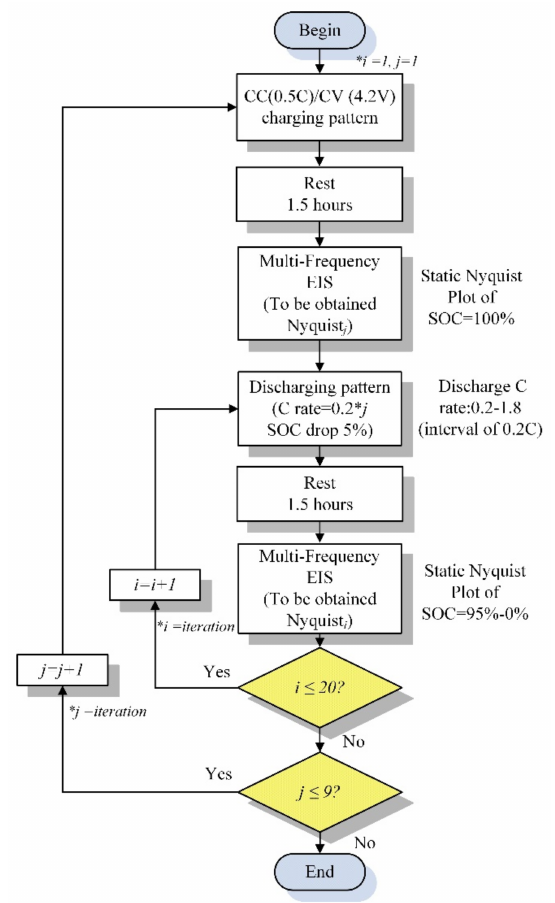
Figure 4. Flowchart of the static SOC data training (initial i =